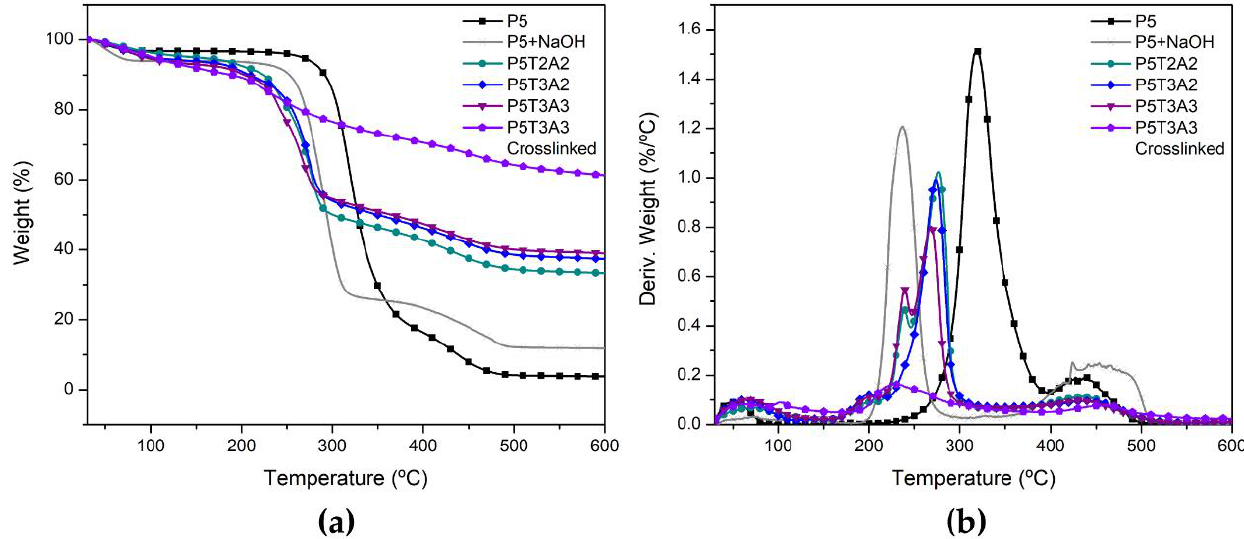
Figure 5. ( a ) TGA weight loss; ( b ) Derivative thermogravimetric curves of PVA/TA/SA aerogels. For the sake of clarity, only P5T3A3 crosslinked aerogel has been represented. See Figure S4 for the rest of the studied samples. Table 4. Thermal degradation of